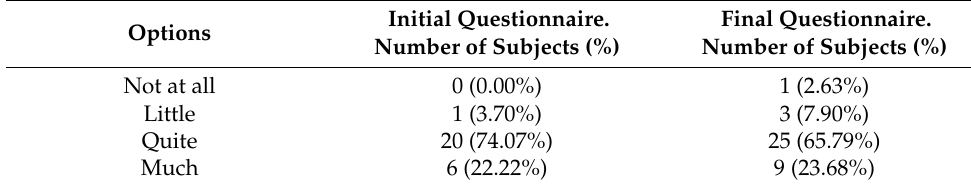
Table 7. Item 5: How helpful this application is when solving dose calculation problems.